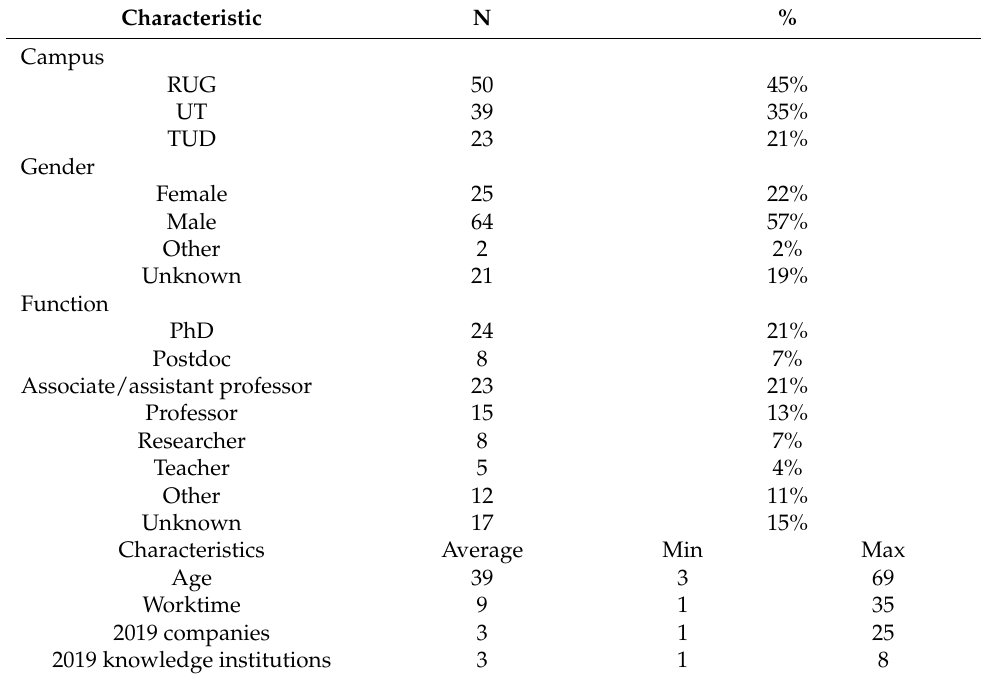
Table A1. Respondent characteristics for company locations.